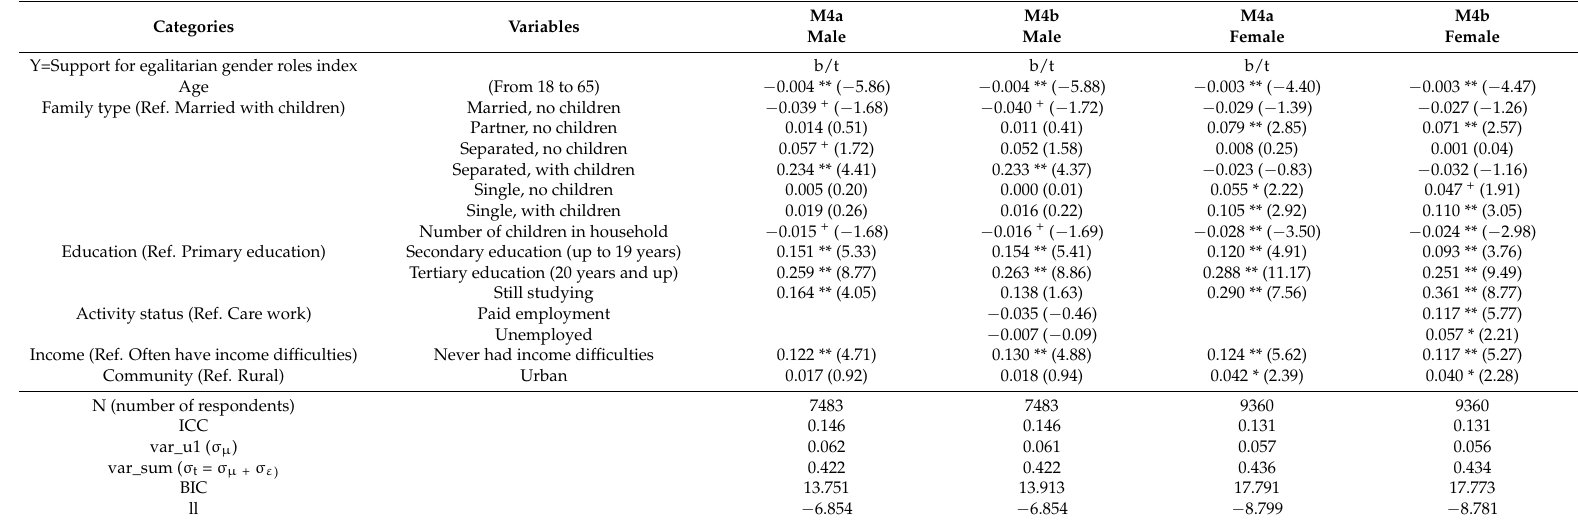
Table 4. Micro-level